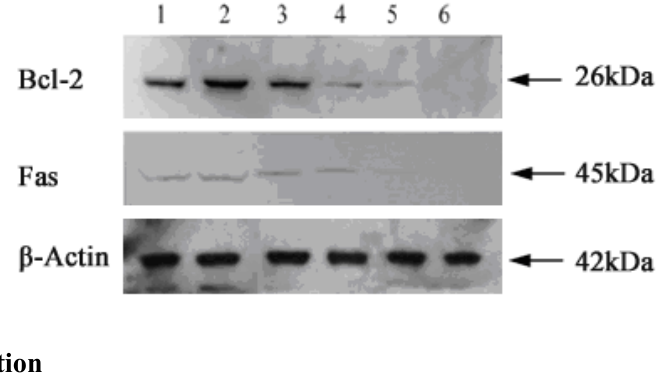
Figure 7. Effect of T α PcZn-PDT on Bcl-2 and Fas respectively in T α PcZn-PDT-induced apoptosis of Bel-7402 cells analyzed by Immunoblot assay. Expression of Bcl-2 and Fas in: Lane 1 , control Bel-7402 cells treated with 0.1% DMSO; Lane 2 , Bel-7402 cells treated with red-light irradiation (53.7 J/cm 2 ); Lane 3 , Bel-7402 cells treated with 54 μ M T α PcZn; and Lane 4~6 , Bel-7402 cells treated with 18, 36, 54 μ M T α PcZn in the presence of red- light irradiation(53.7 J/cm 2 ),